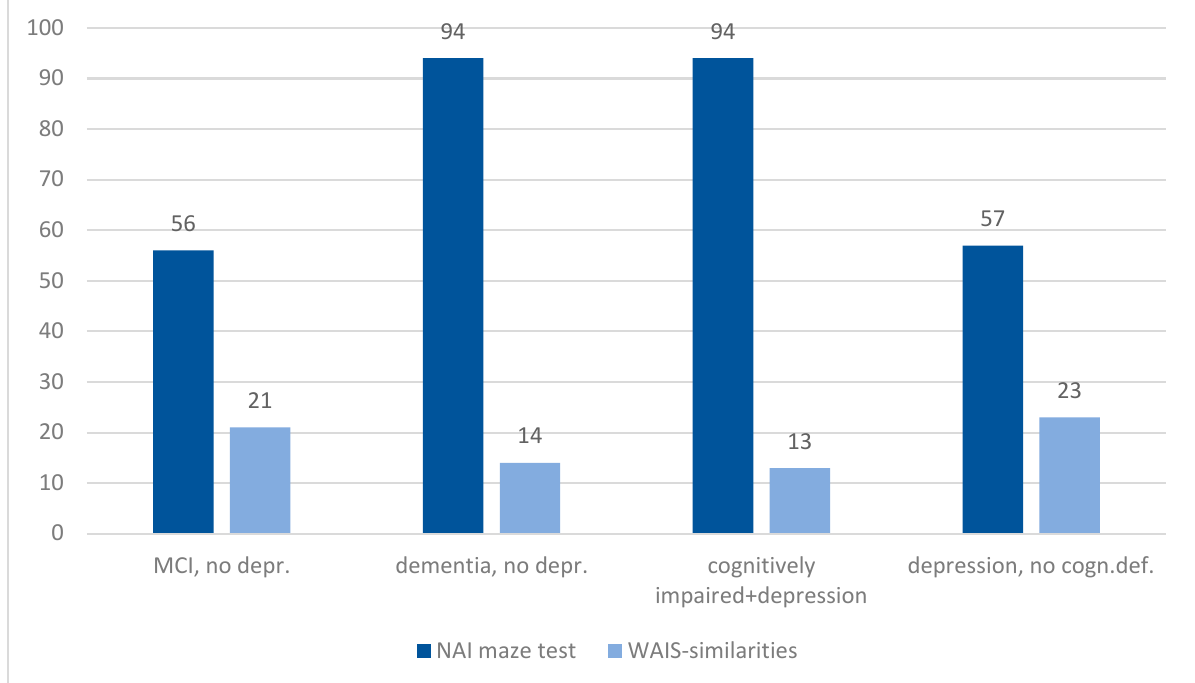
Figure 4. Test profiles of the individual diagnosis groups.